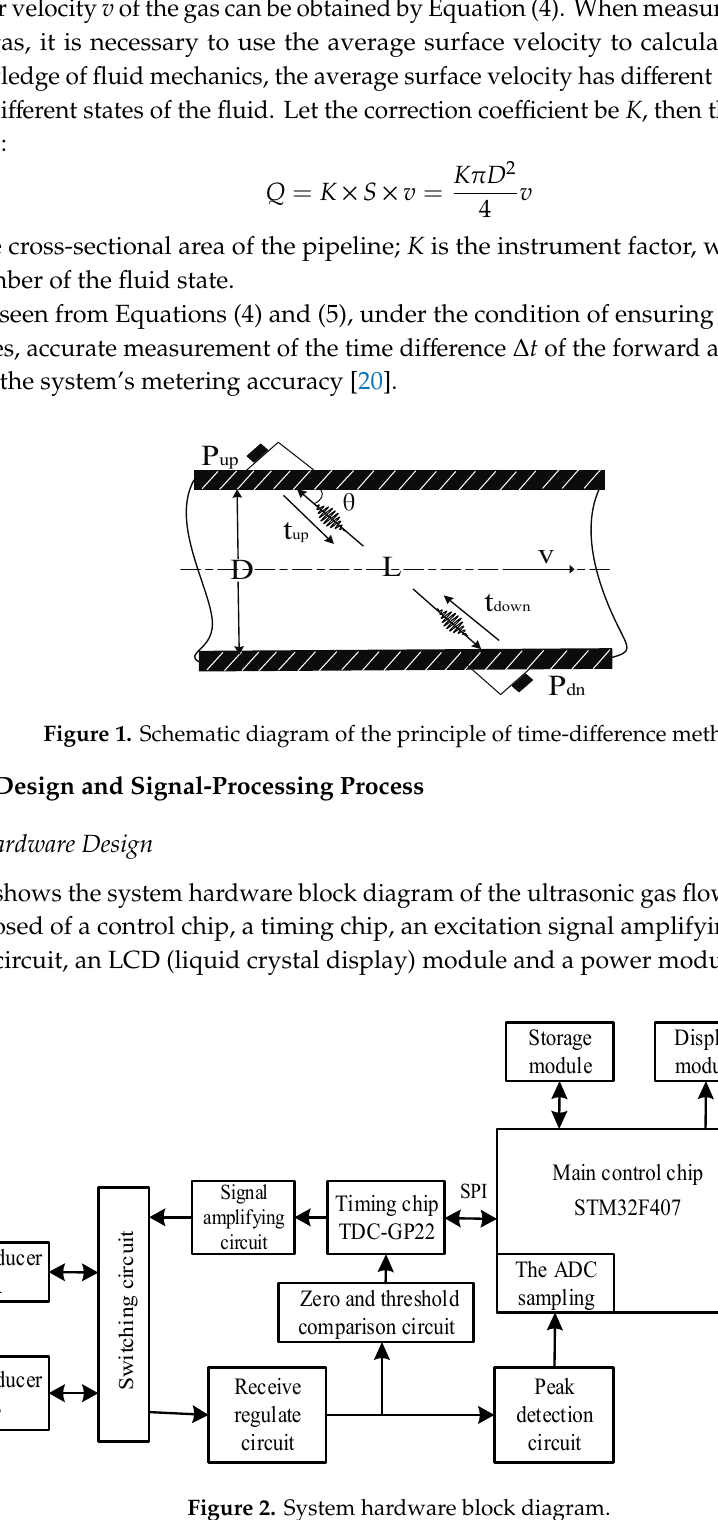
Figure 2. System hardware block diagram.